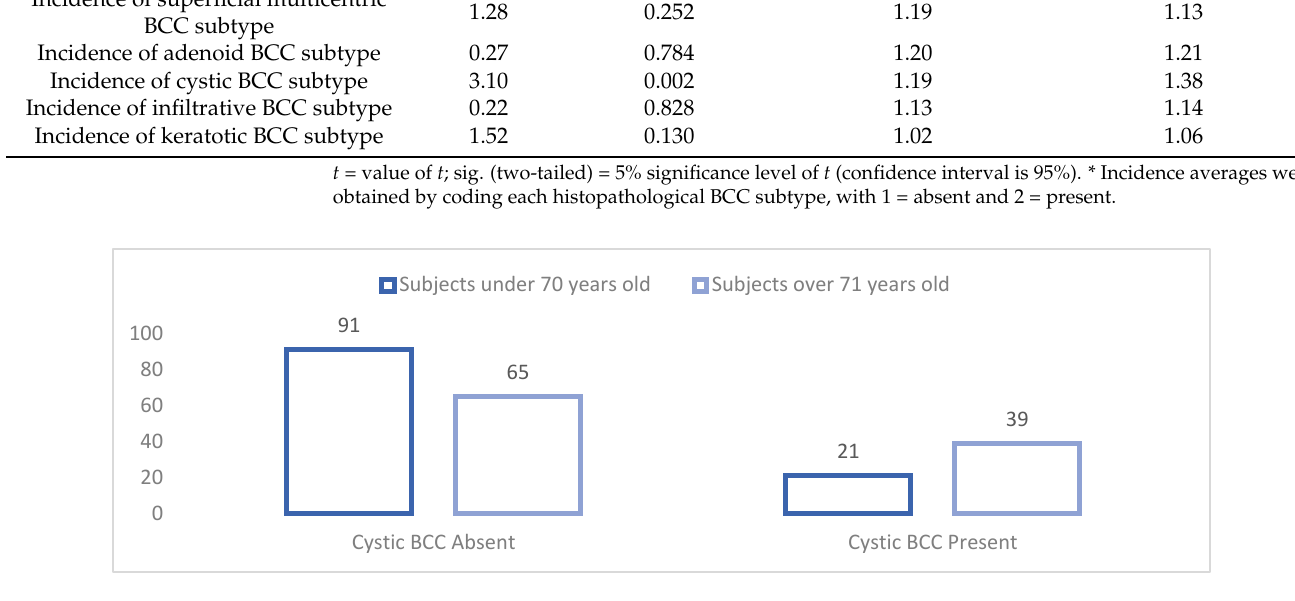
Table 6. Comparison of the incidence of the six histopathological BCC subtypes depending on whether the subjects were from an urban or rural environment.